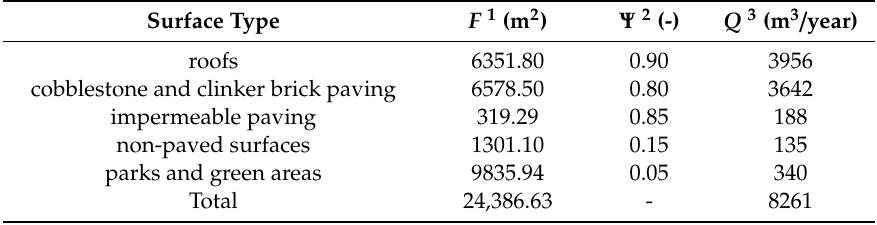
Table 4. Runo ff volume after the completion of the